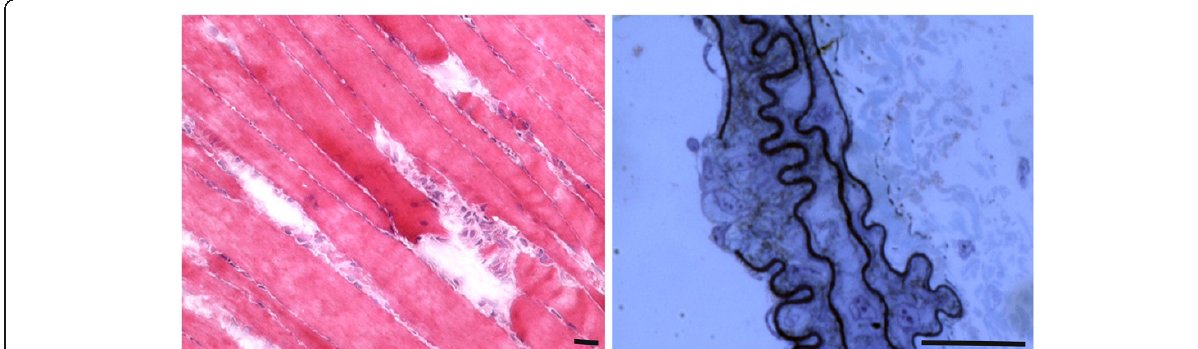
Figure 1 Examples of focal injuries. (LEFT) Hematoxilin-and eosin-stained murine skeletal muscle, longitudinally sectioned to show the gaps in three adjacent fibers. The injury likely occurred following an intense exercise session (wheel running). Upon leakage of the broken sarcolemma, factors such as Wnt are released before a fast repair process known as patch repair occurs. In turn, Wnt factors trigger the activation of satellite cells and other resident interstitial cells with myogenic potential, which proliferate, migrate and fuse into small myotubes that ultimately fuse with the damaged fibers. (RIGHT) Toluidine blue-stained semithin section of a murine carotid showing damage, likely due to smooth muscle cell-restricted inactivation of the serum response factor gene. A rupture of the endothelial layer, as well as of the elastin matrix, with exposure of underlying cells is visible; release of intracellular factors (von Willebrand Factor) and exposure of undisclosed antigens (collagen) are essential for the subsequent phases of clot formation, remodeling and repair of the wall defect. Bar = 25 micron.